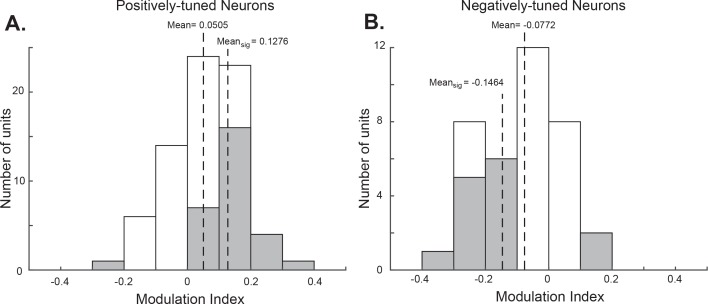
Attentional modulation indices of the value-encoding OFC neurons.The grey bars indicate neurons with significant attentional modulation. Mean values of all value-encoding neurons and those with significant attentional modulations are indicated by the dashed lines respectively. All of them are significantly different from zero (for all the positively tuned neurons, p=1.10e-4; for the positively tuned neurons with significant attentional modulation, p=4.06e-8, for all the negatively tuned neurons, p=3.04e-4; and for the negatively tuned neurons with significant attentional modulation, p=0.0016).